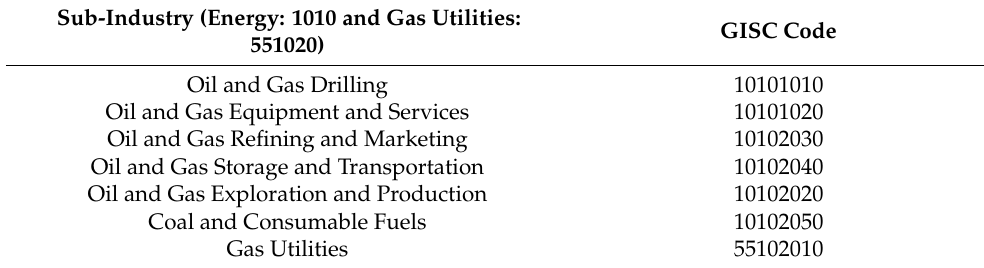
Table 1. Sub-industry structure with GISC code. Sub-Industry (Energy: 1010 and Gas